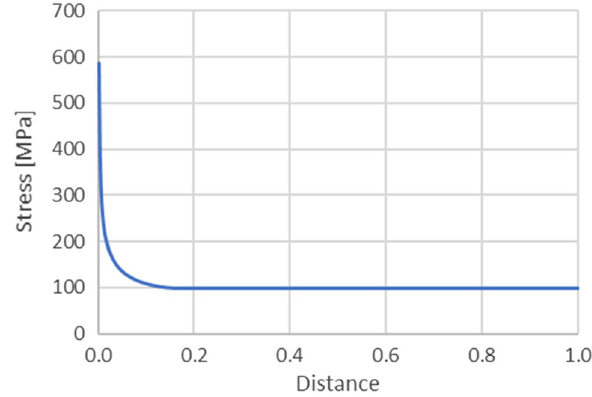
Fig. 14 1-D stress profile for plate with 120-degree v-notch